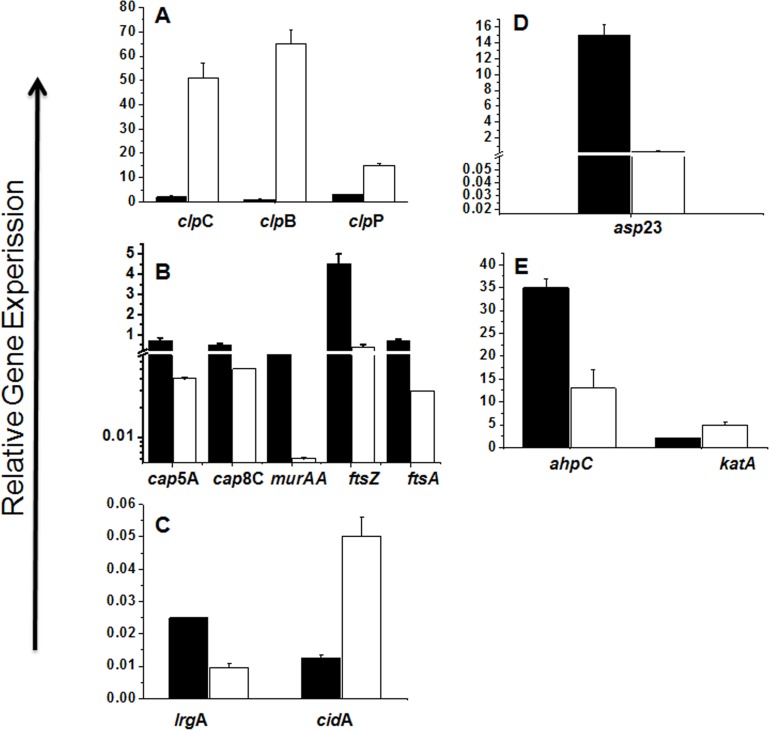
Effect of kendomycin on the transcription of selected genes in S. aureus COL.S. aureus COL cells were grown in BHI medium to mid-exponential growth phase, and subsequently supplemented with kendomycin (1.5 x MIC, white bars) or left untreated (black bars). One hour after drug addition, cells were harvested and used for total RNA isolation. A) Transcription of the heat shock protein encoding genes clpC, clpB and clpP. B) Transcription of the capsule operon genes cap5A and cap8C, the UDP-N-acetylglucosamine1-caboxyphenyltransferase encoding gene murAA, and the septum formation factors encoding genes ftsA and ftsZ. C) Transcription of the programmed cell death factor encoding genes cidA and lrgA. D) Transcription of the SigmaB activity marker gene asp23. E) Transcription of the H2O2 inactivating factor encoding genes ahpC and katA. mRNA levels are expressed relative to gyrase B (in numbers of copies per copy of gyrB). The data presented are the mean ± SD of four independent experiments.